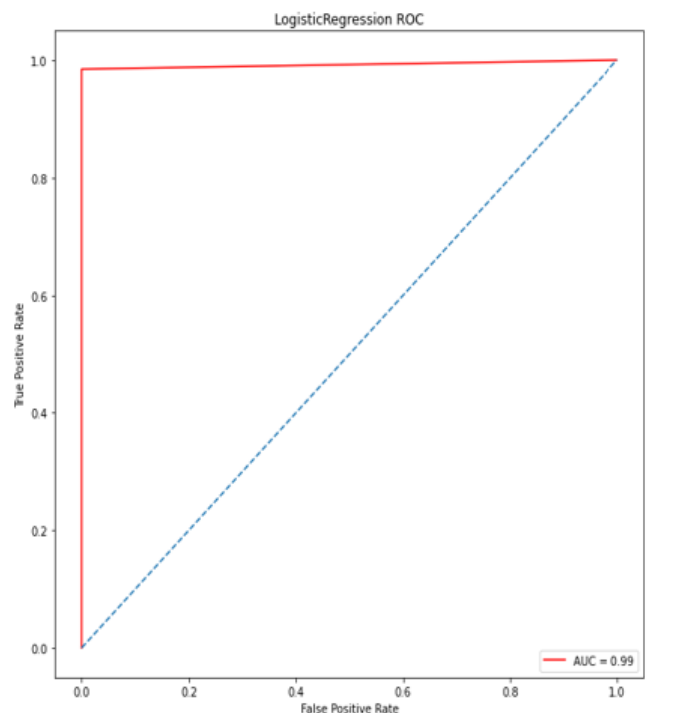
Figure 13. ROC/AUC of Logistic Regression.